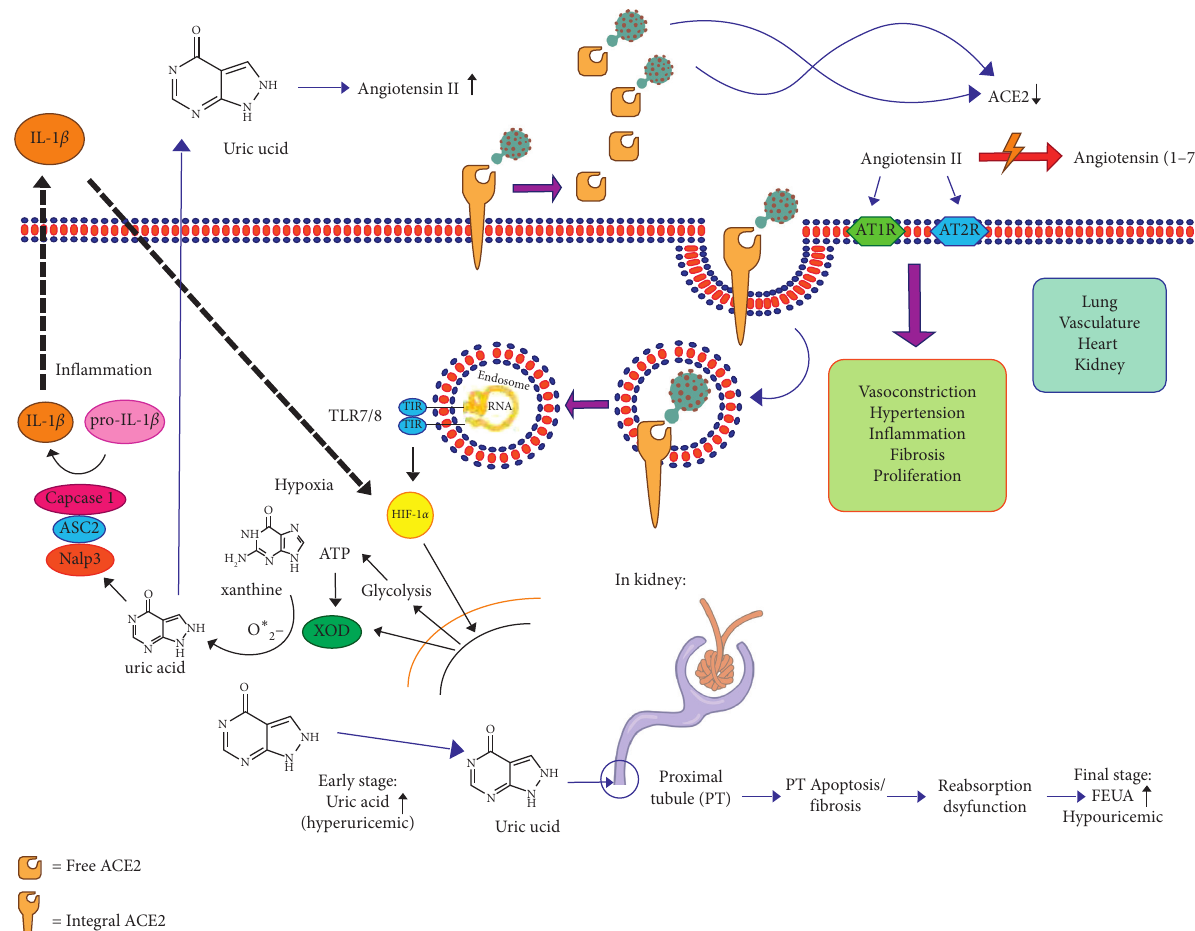
Figure 2: Association between XO activity and uric acid level and kidney tubulus